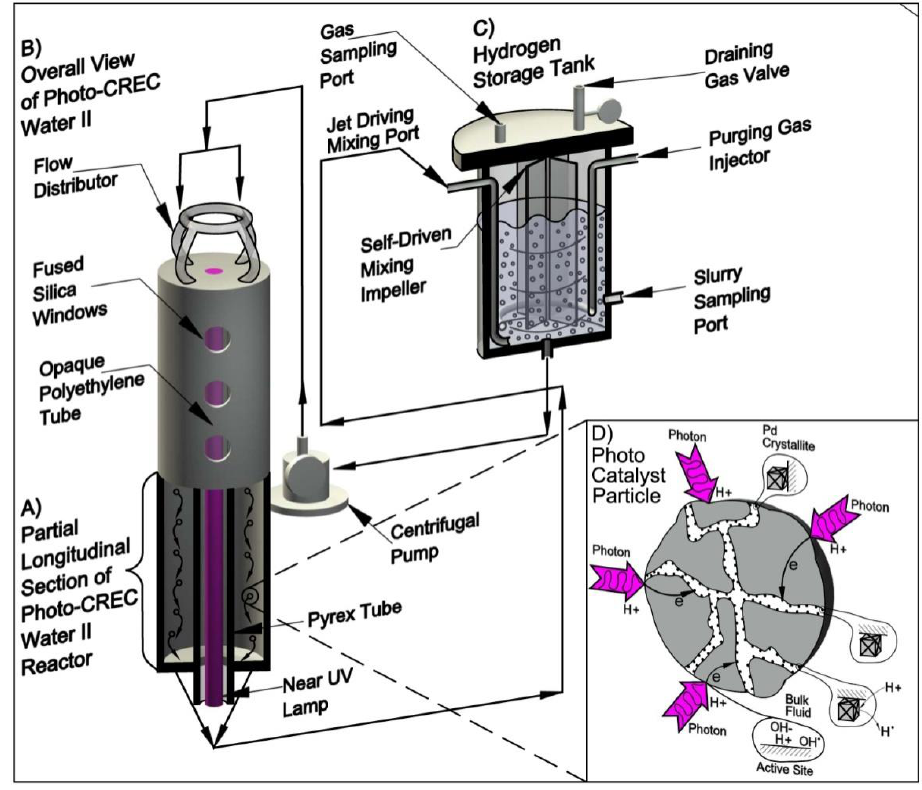
Figure 15. Schematic representation of the Photo-CREC Water II Reactor with a H 2 Mixing/Storage Tank: ( A ) partial longitudinal cross-section of the PCW- II unit showing the down flow circulation of the slurry in the annular channel, ( B ) overall view of PCW-II showing windows, near UV lamp and recirculation pump ( C ) hydrogen storage tank with its components, ( D ) detail of a photocatalyst particle.